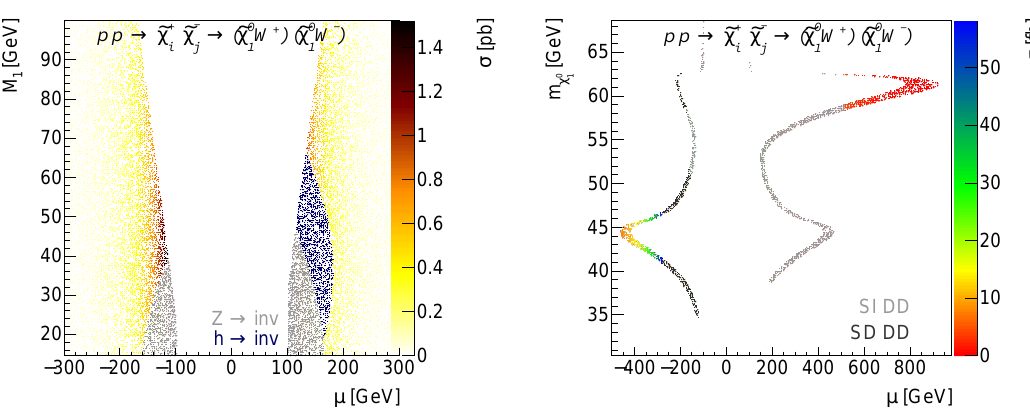
Figure 12: Cross section for the mono- W -pair process in the µ − M to Fig. 11. Left: points fulfilling the chargino mass bound, shown with the limits on invisible Z and Higgs decays. Right: points also predicting the correct relic density, shown with DD bounds.